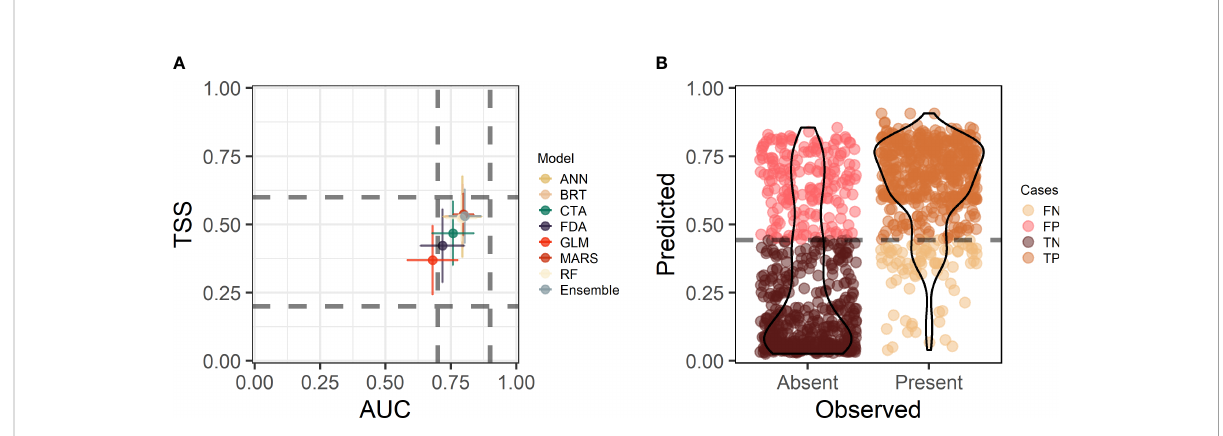
FIGURE 2 Eelgrass species distribution model performance evaluations: (A) Two evaluation statistics (AUC, TSS) for 7 modeling methods (ANN, BRT, CTA, FDA, GLM, MARS, RF) and the ensemble model. Points are the mean values (± SD) across 5 cross-validation runs. Dashed lines identify thresholds of model performance on each statistic. Below the fi rst horizontal or vertical dashed lines is poor performance, between the fi rst and second lines indicates moderate performance, and above the second horizontal or vertical lines is good performance. (B) Graphical representation of the confusion matrix for the ensemble model. Model predicted (probability) vs. observed (Absent, Present) occurrence of eelgrass. The dashed line is the threshold probability classifying predictions into presence − absence based on the average value across cross- validation runs that maximized the value of the TSS. Colours identify correctly classi fi ed (TP, true positive; TN, true negative) vs. misclassi fi ed (FP, false positive; FN, false negative)